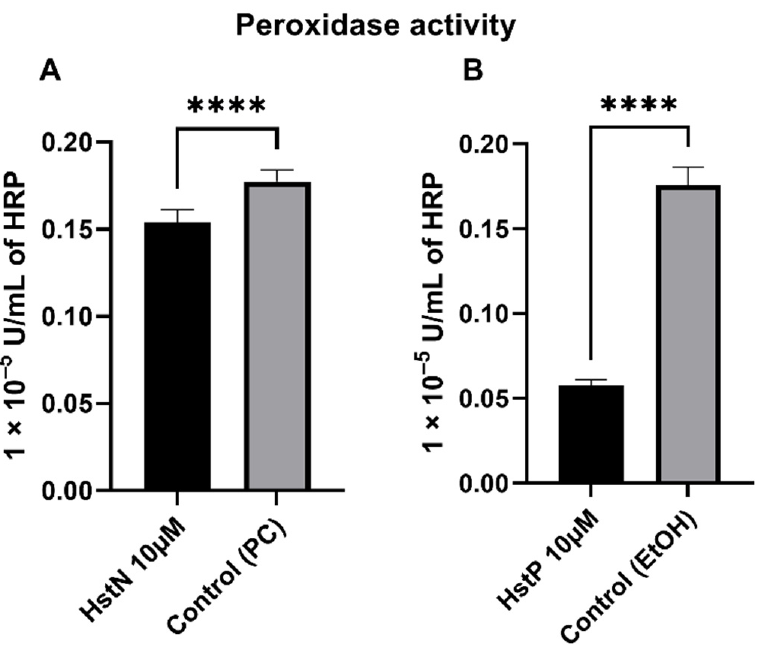
Figure 6. Effect of HstN and HstP on peroxidase activity in SH-SY5Y-APP 695 cells. Peroxidase activ- ity in SH-SY5Y-APP 695 cells: ( A ) incubated for 24 h with HstN, with PC as control, and ( B ) incubated for 24 h with HstP, with ethanol as control. Respective mean values ± SD are shown, N = 10. Signif- icance was determined by unpaired Student’s t-test. **** p < 0.0001. HstN, hesperetin nanocrystal; HstP, hesperetin in pure form; PC, PlantaCare; EtOH, ethanol .